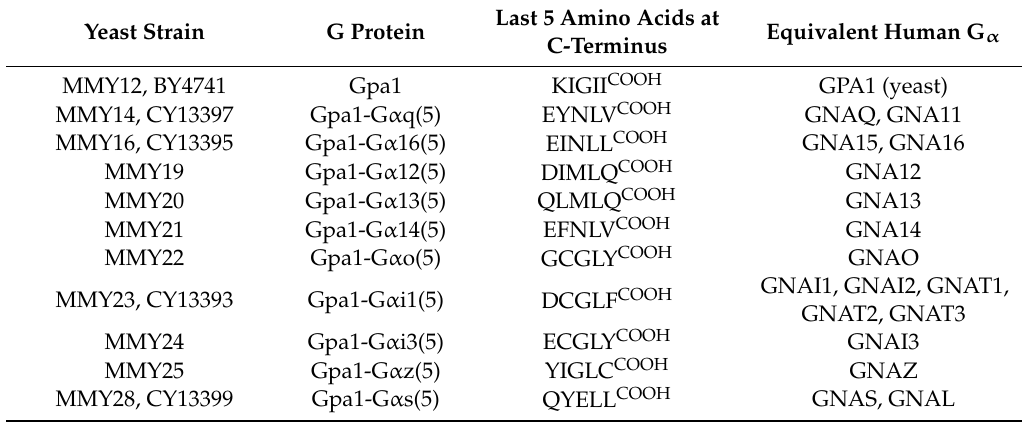
Table 1. List of yeast strains used in this study